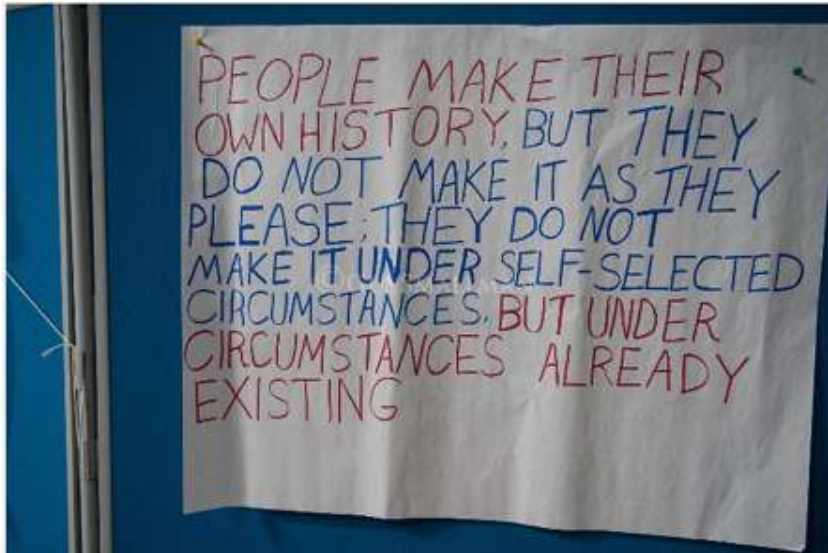
Figure 2. Referencing Marx